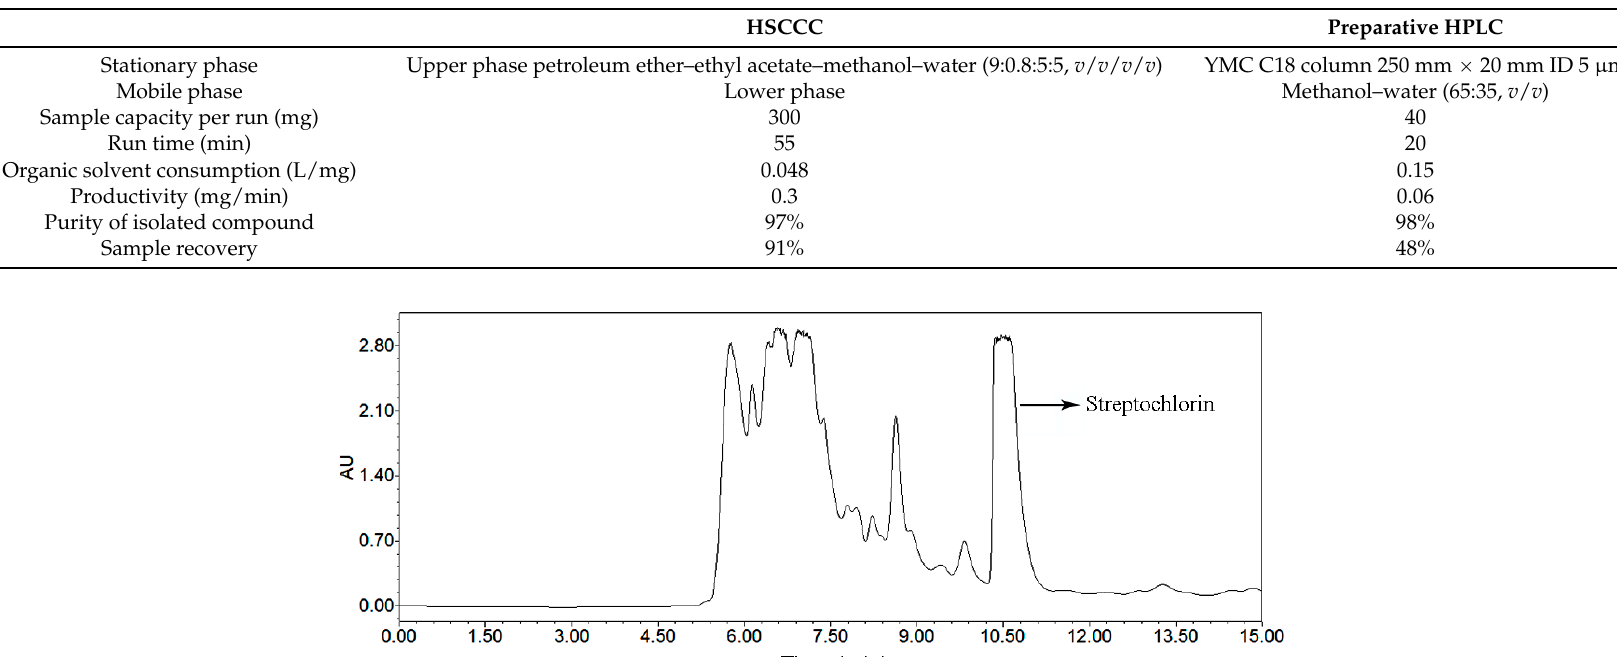
Table 6. Comparison of HSCCC and Preparative HPLC.